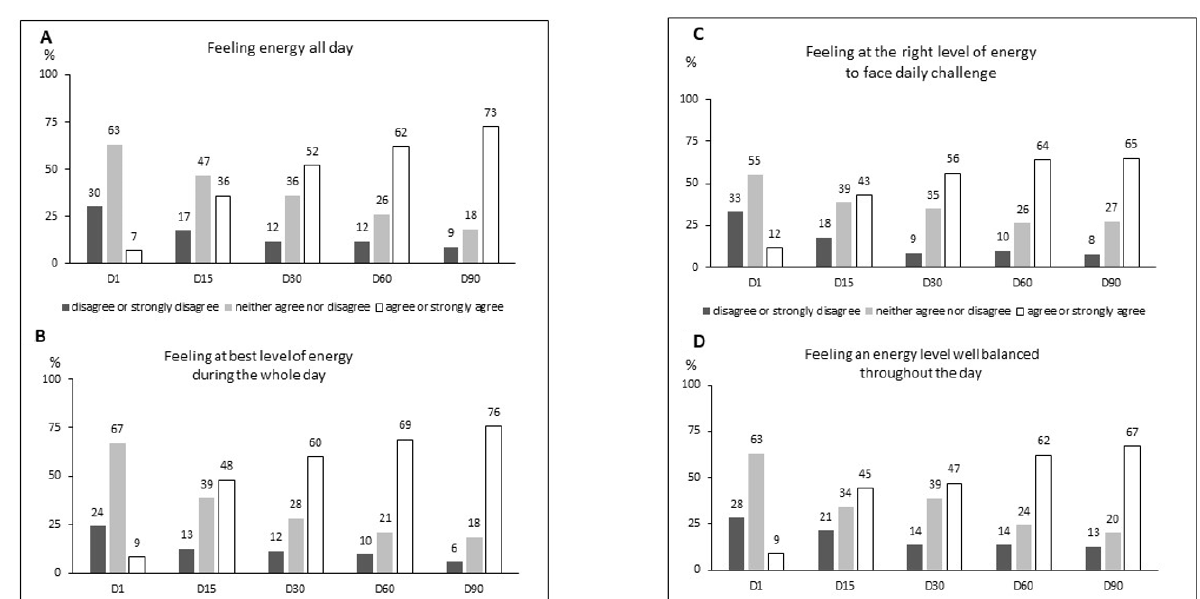
Figure 2. Percentage of population self-reporting the indicated level of agreement with proposed statements evaluating satisfaction vs. “feeling energy all day” ( A ), “feeling at best level of energy during the whole day” ( B ), “feeling at the right level of energy to face daily challenge” ( C ) or “feeling an energy level well balanced throughout the day” ( D ) from D1 to D90 following supplementation. D—day.